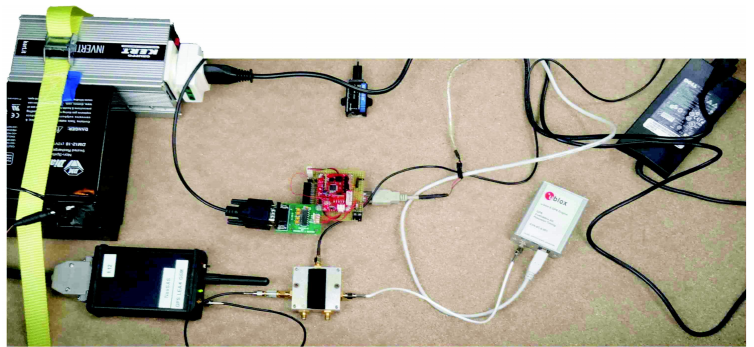
Figure 19. Experimental setup mounted inside the test